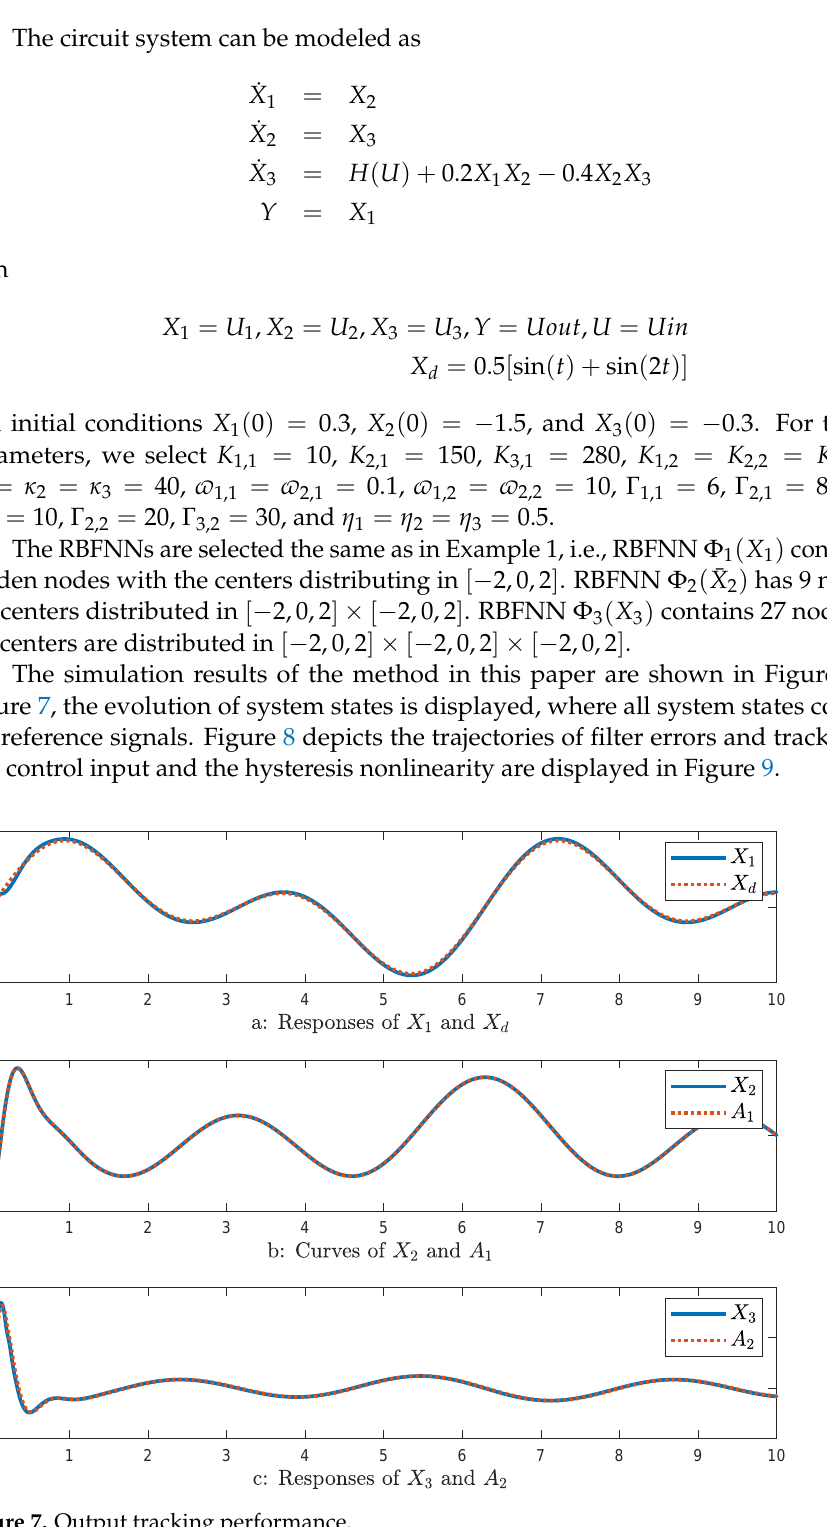
Figure 7. Output tracking